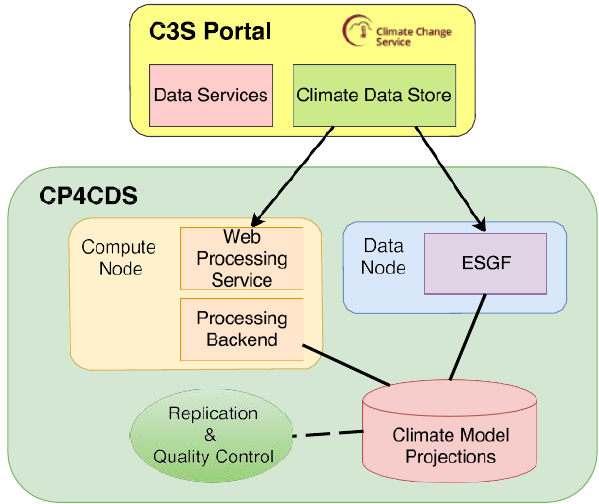
Figure 1. CP4CDS Architecture